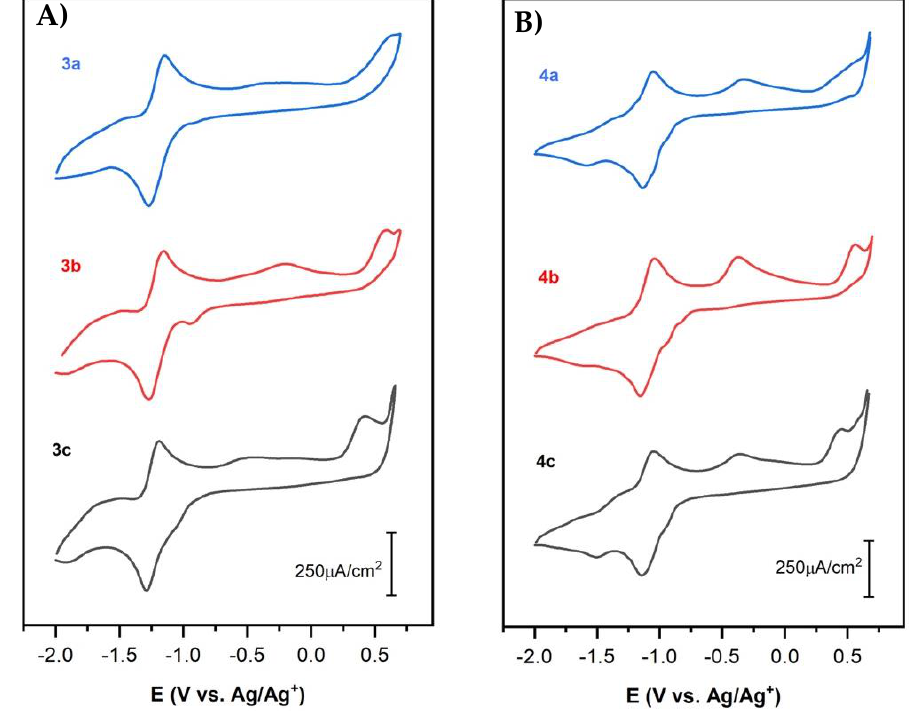
Figure 2. Cyclic voltammetry curves of ( A ) naphthoquinone (3a–c) and ( B ) chloride-naphthoquinone (4a–c) derivatives with a: tyrosine, b: valine and c: tryptophan at 5 mM in 0.1 M TBABF 4 // DMSO at room temperature. Scan rate: 100 mV s −1 .